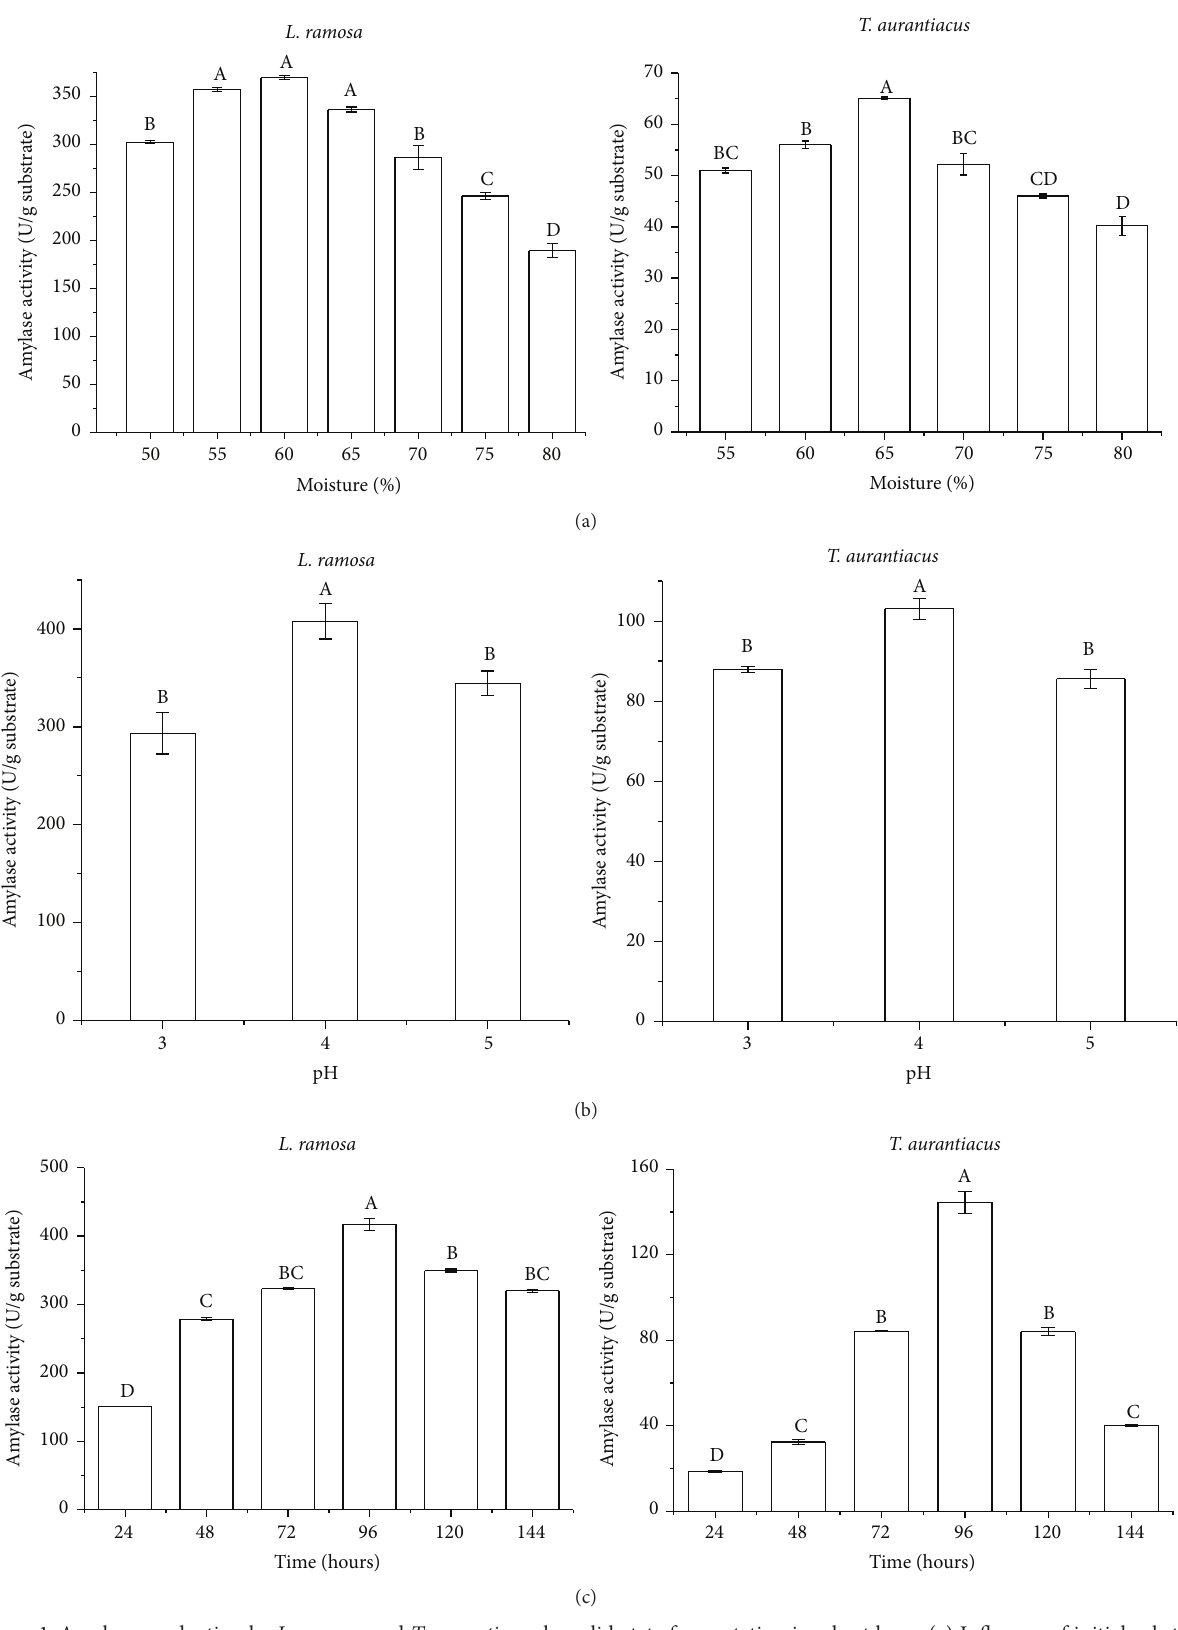
Figure 1: Amylase production by L. ramosa and T. aurantiacus by solid-state fermentation in wheat bran. (a) Influence of initial substrate moisture; (b) influence of initial cultivation pH; (c) influence of cultivation time. Average production with different letters indicates significant differences according to Tukey